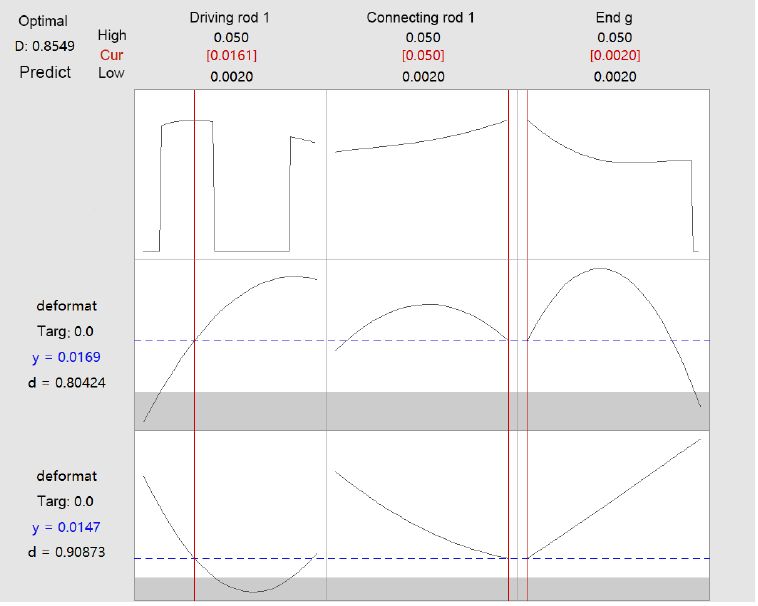
Figure 21. Optimization diagram of member damping design.